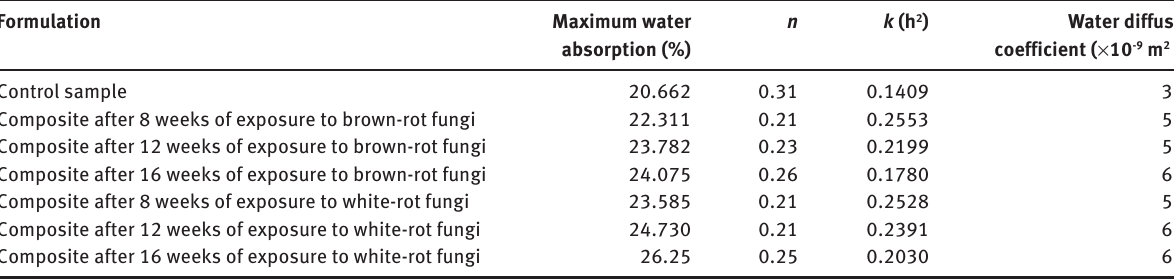
Table 1 Water diffusion, maximum water absorption, n and k coefficients for all